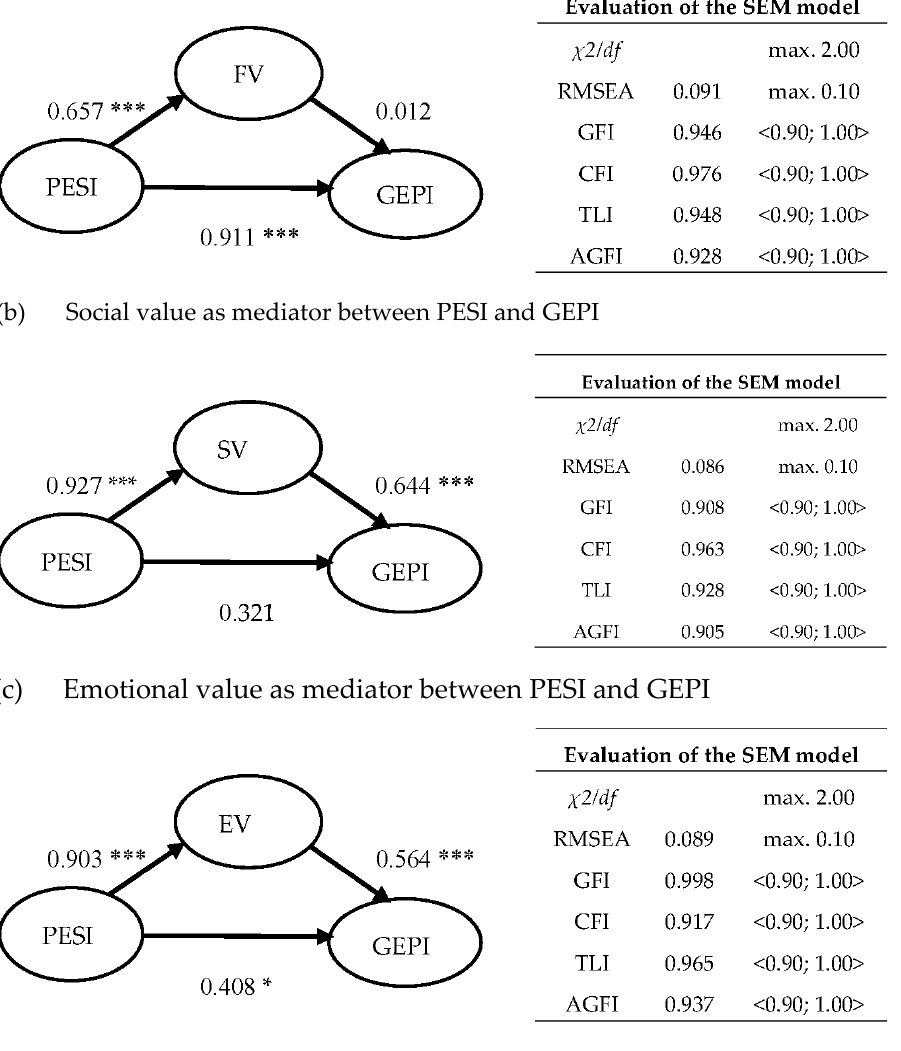
Figure 1. SEM models of direct and indirect (mediation) effect; Note. N = 250; significance level for p < 0.01 (***); significance level for p < 0.05 (*). Table 4. Results of structural equation